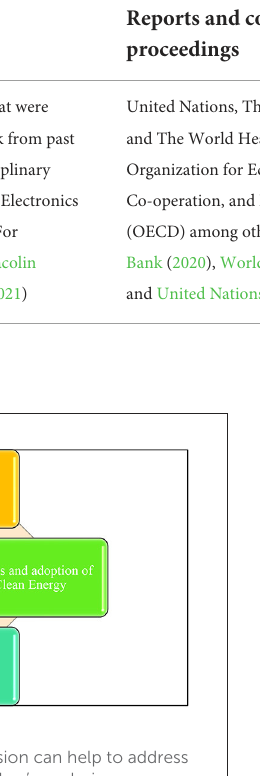
TABLE 1 The main documents used in summative content